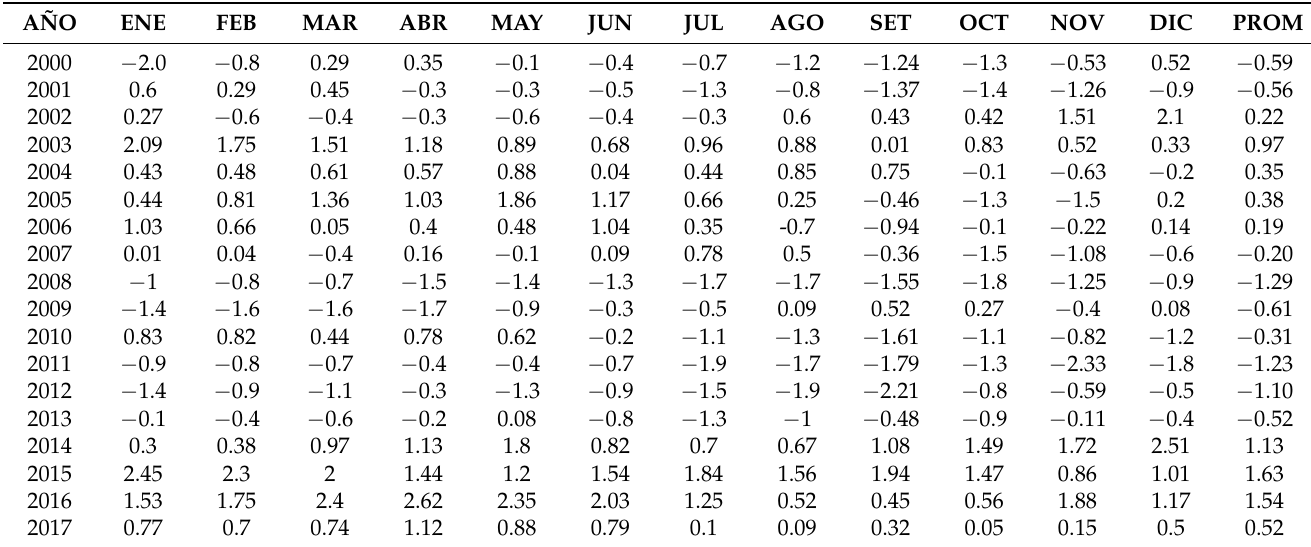
Table A3. PDO Index data, during the years 2000 to